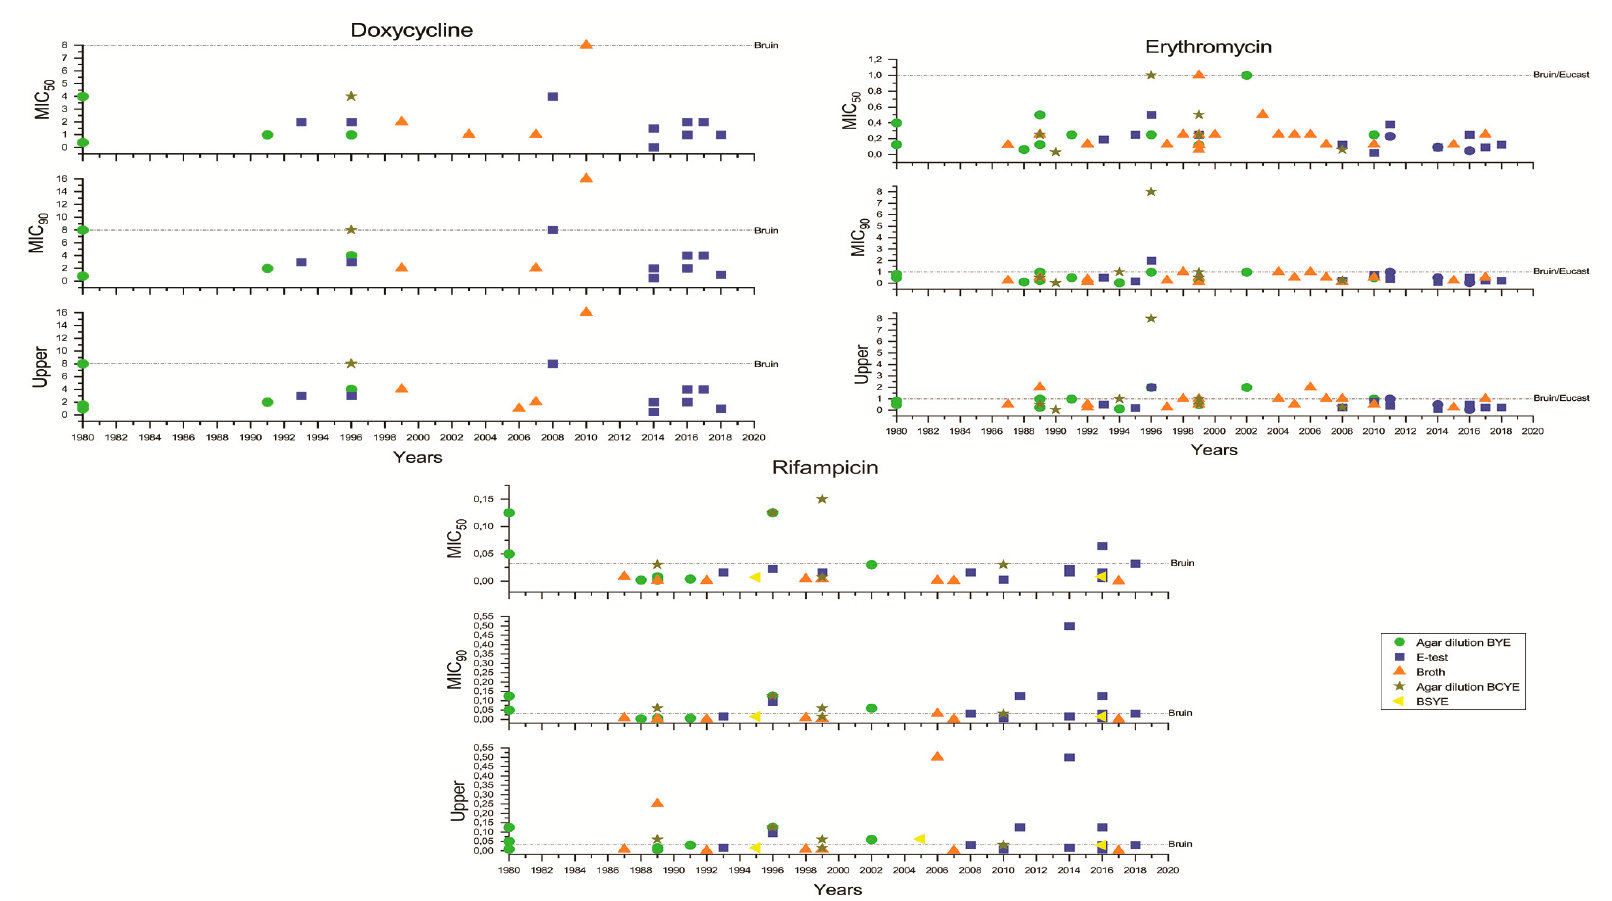
Figure 3. Distribution of MICs of ciprofloxacin, levofloxacin, azithromycin and clarithromycin based on different methodologies (Agar dilution on Buffered Yeast Extract (BYE), E-test, Broth dilution, Agar dilution on Buffered Yeast Charcoal Extract (BCYE), and Buffered Starch Yeast Extract (BSYE) plating). The epidemiological cut-off values proposed by Bruin et al. [29] and by the EUCAST (where available; 32) are shown as dotted horizontal lines .